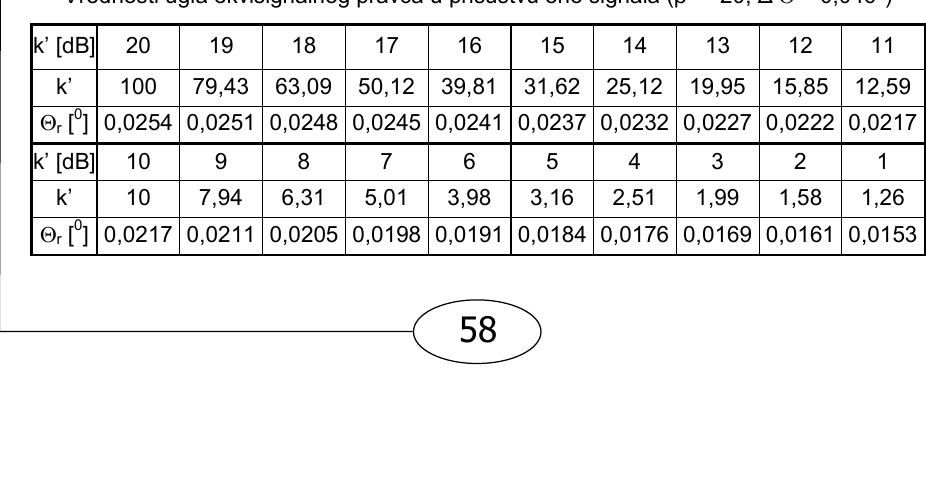
Sl. 9 – Ugao ekvisignalnog pravca u prisustvu eho signala i bez njega Sa slike 9 može se videti da za velike odnose snaga signala ometanja ni- je bitno da li je eho signal prisutan ili ne (krive se gotovo poklapaju), dok se za manje odnose snaga signala ( β >-5) može primetiti ve ć i nagib krive kada ne- ma eho signala, što navodi na zaklju č ak da ć e i efekat ometanja biti ve ć i. Ako se posmatra uticaj ja č ine snage signala ometanja u odnosu na koristan signal na osnovu izraza (44) dobijaju se vrednosti date u tabeli 3. Tabela 3 Vrednosti ugla ekvisignalnog pravca u prisustvu eho signala ( β = -20, Δ Θ = 0,046 0